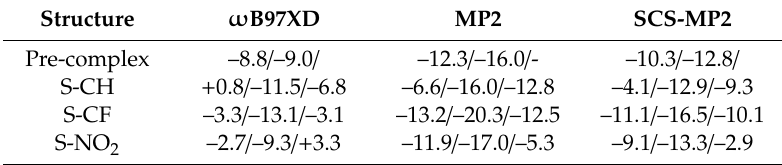
Table 2. Stabilities (only thiolate/thiolate and imidazolium: full optimization/thiolate and imidazolium: R(S-CX) fixed at 1.9 Å) of the Meisenheimer complexes in a polar solvent [in kcal/mol].